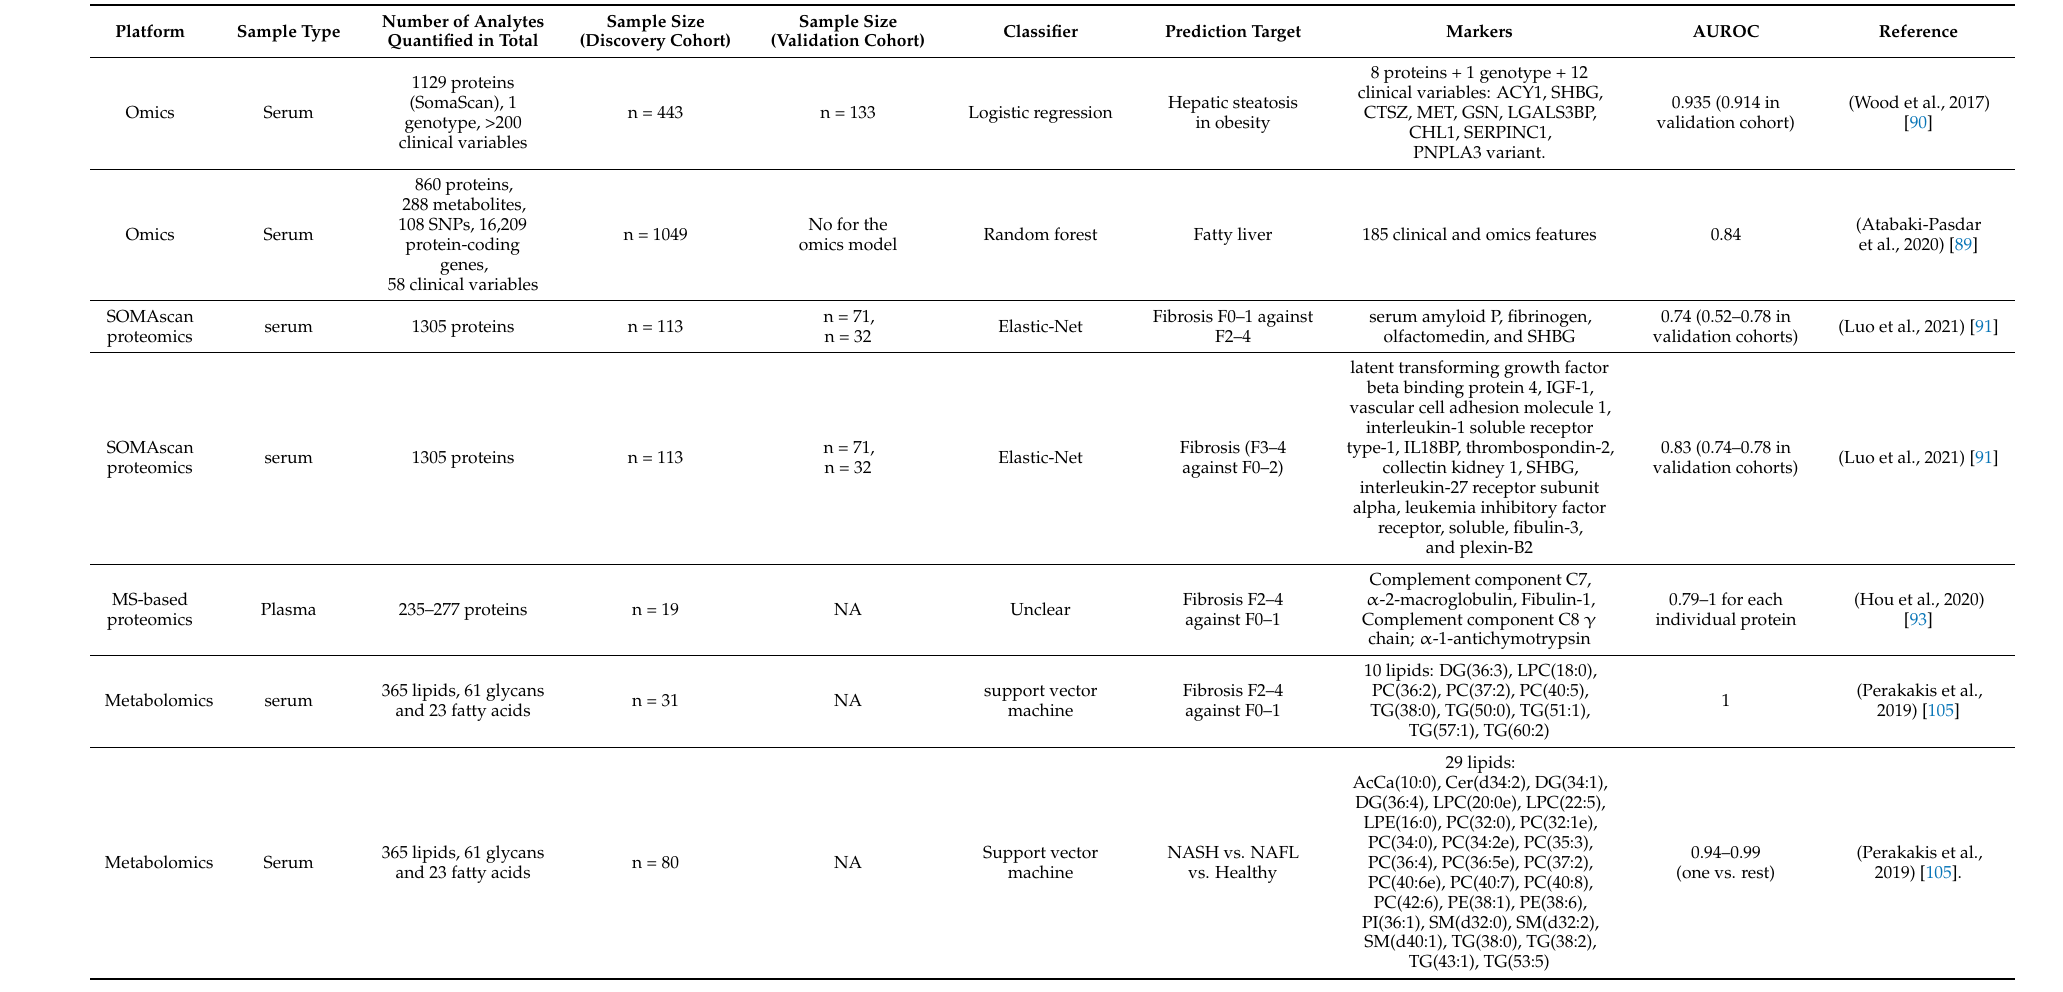
Table 3. Emerging omics markers and their classification performance for diagnosing